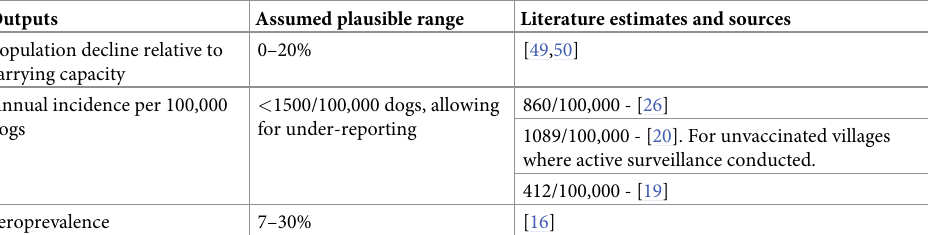
Table 3. Assumed plausible ranges of population decline, annual incidence per 100,000 dogs and seroprevalence for comparison to model